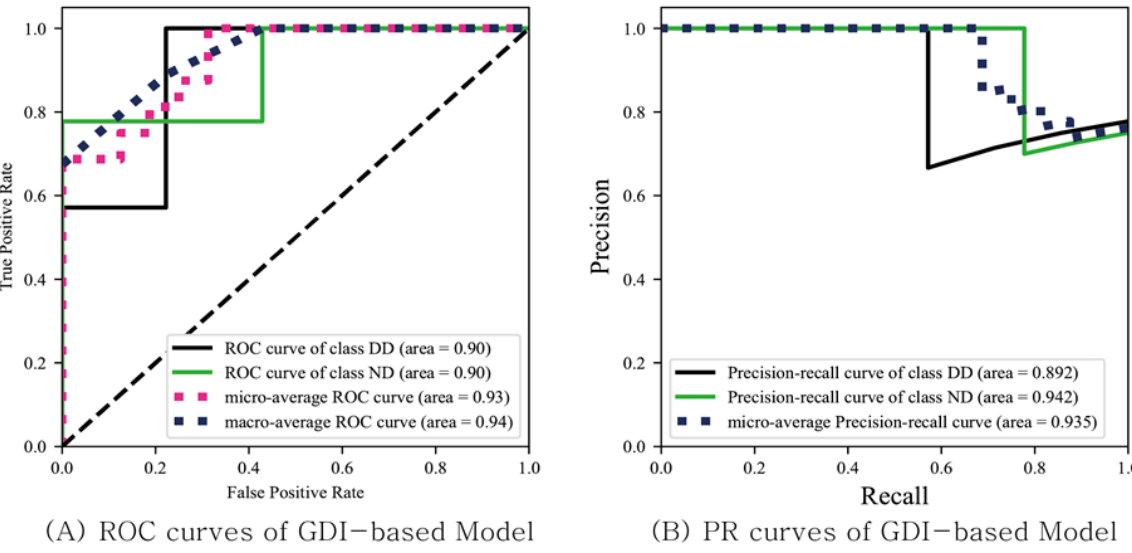
Figure 4. The receiver operating characteristic and precision-recall curves for leave-one-out cross validation of the model based on the game-derived index from the serious game. ROC: receiver operating characteristic; DD: developmental disabilities; ND: normal development; PR: precision recall; GDI: game-derived index.